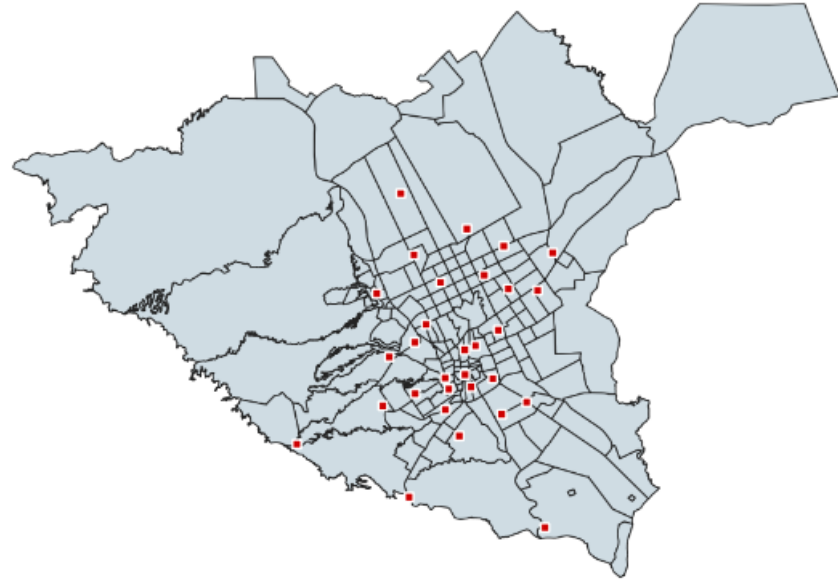
Figure 7. Locations of 30 EMS ambulance unit stations in